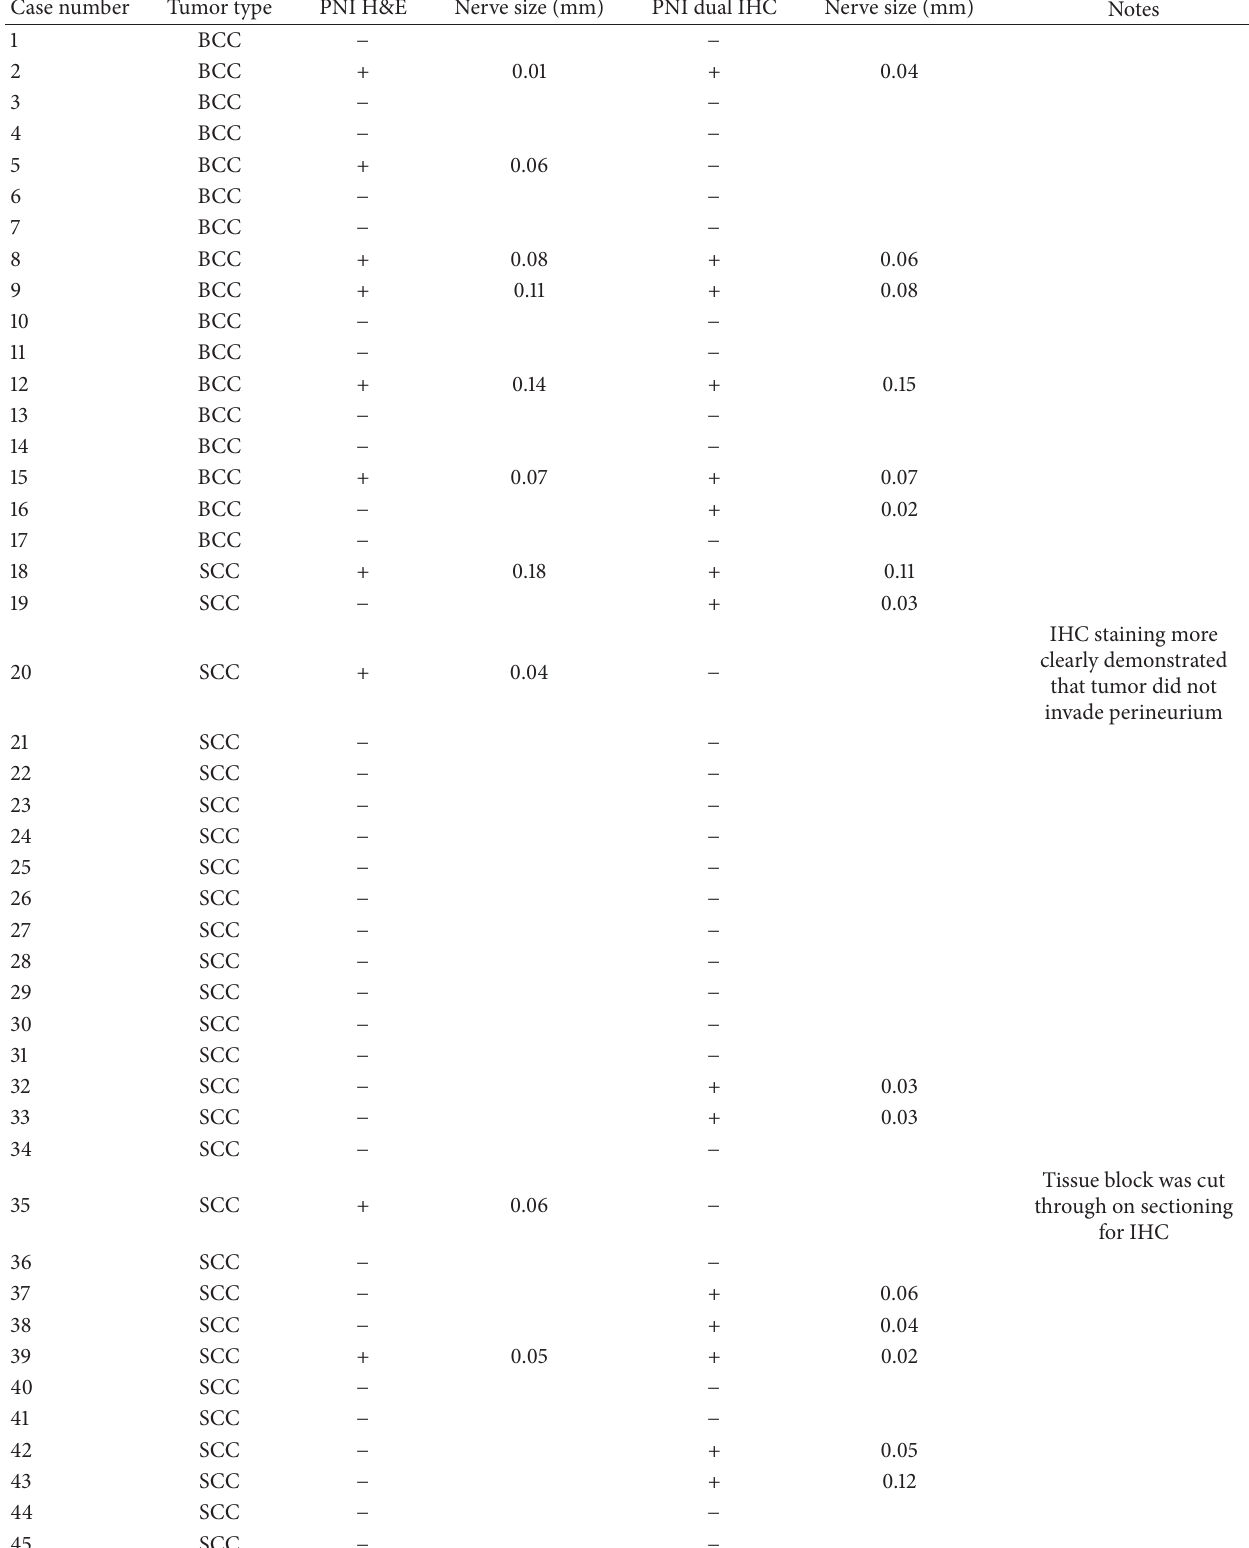
Table 1: Detection of PNI on H&E and dual IHC